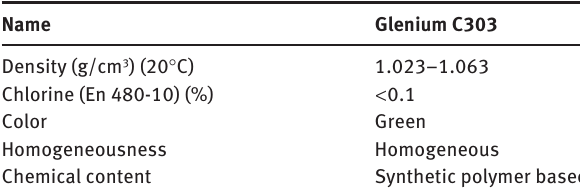
Table 5 Technical properties of superplasticizer.